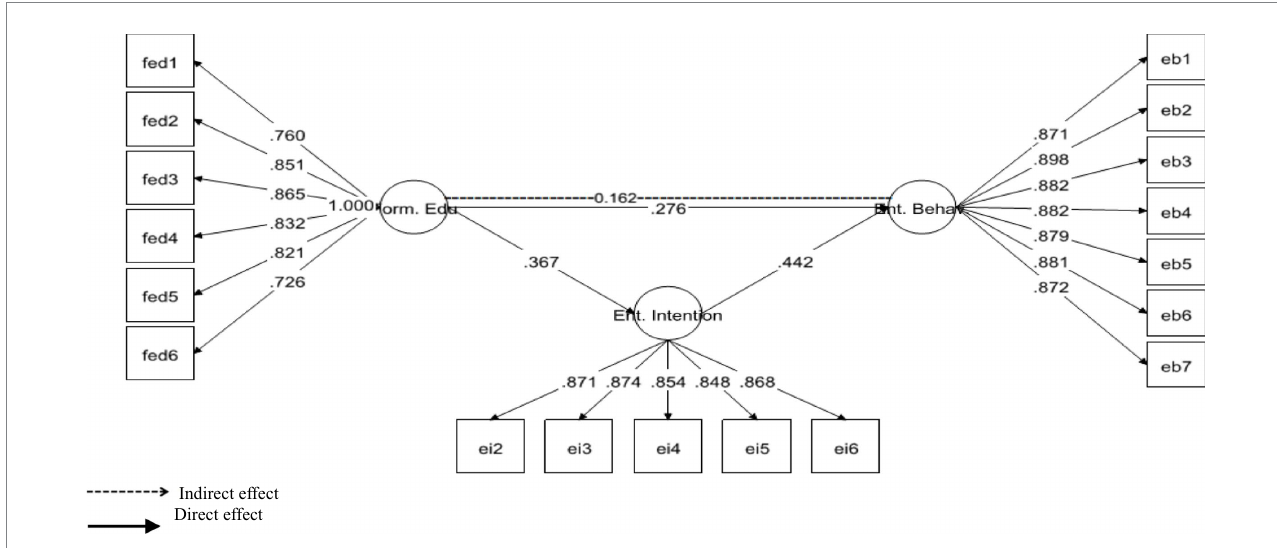
FIGURE 3 Mediation of entrepreneurial intention (Ent. Intention) between formal education (Form. Edu) and entrepreneurial behavior (Ent.